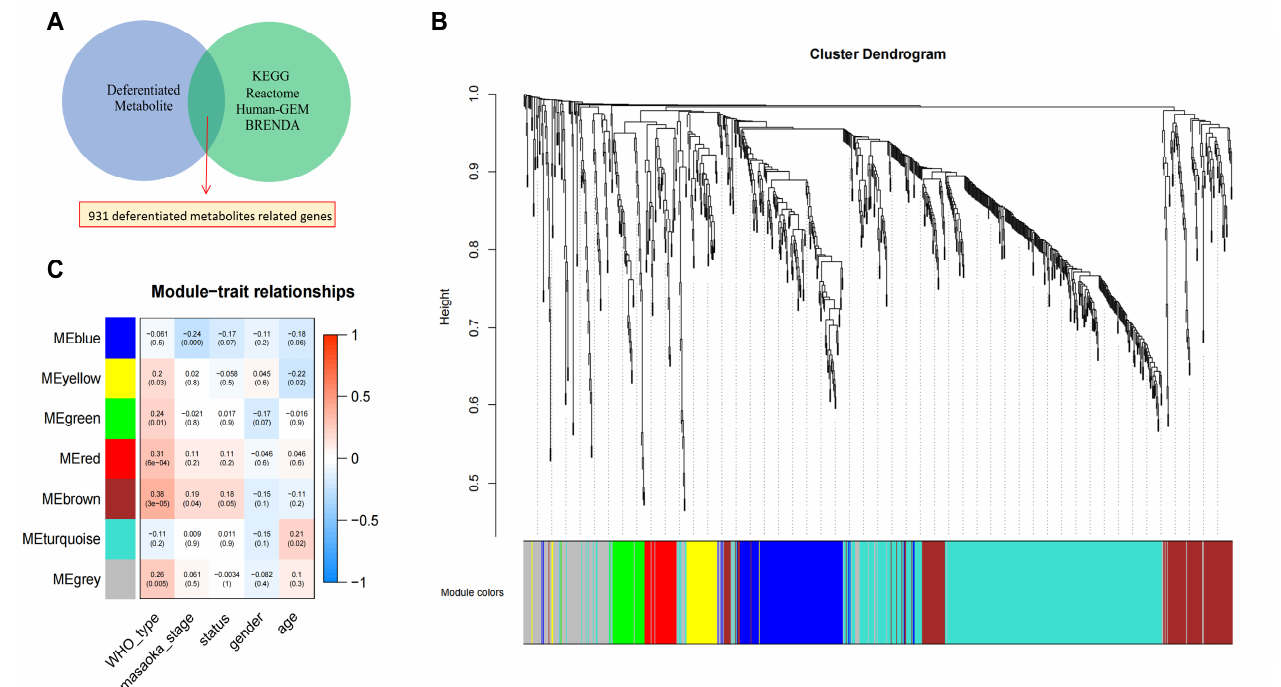
Figure 2. Identification of metabolite-related genes and WGCNA. ( A ) Venn diagrams of differentiated metabolite-related genes from metabolite–protein interactions. ( B ) Hierarchical clustering tree for 931 MRGs. ( C ) Module–trait relationship heatmap based on the Pearson correlation coefficient between module eigengenes and clinical parameters (WHO histological type, Masaoka stage, sur- vival status, sex, and age).